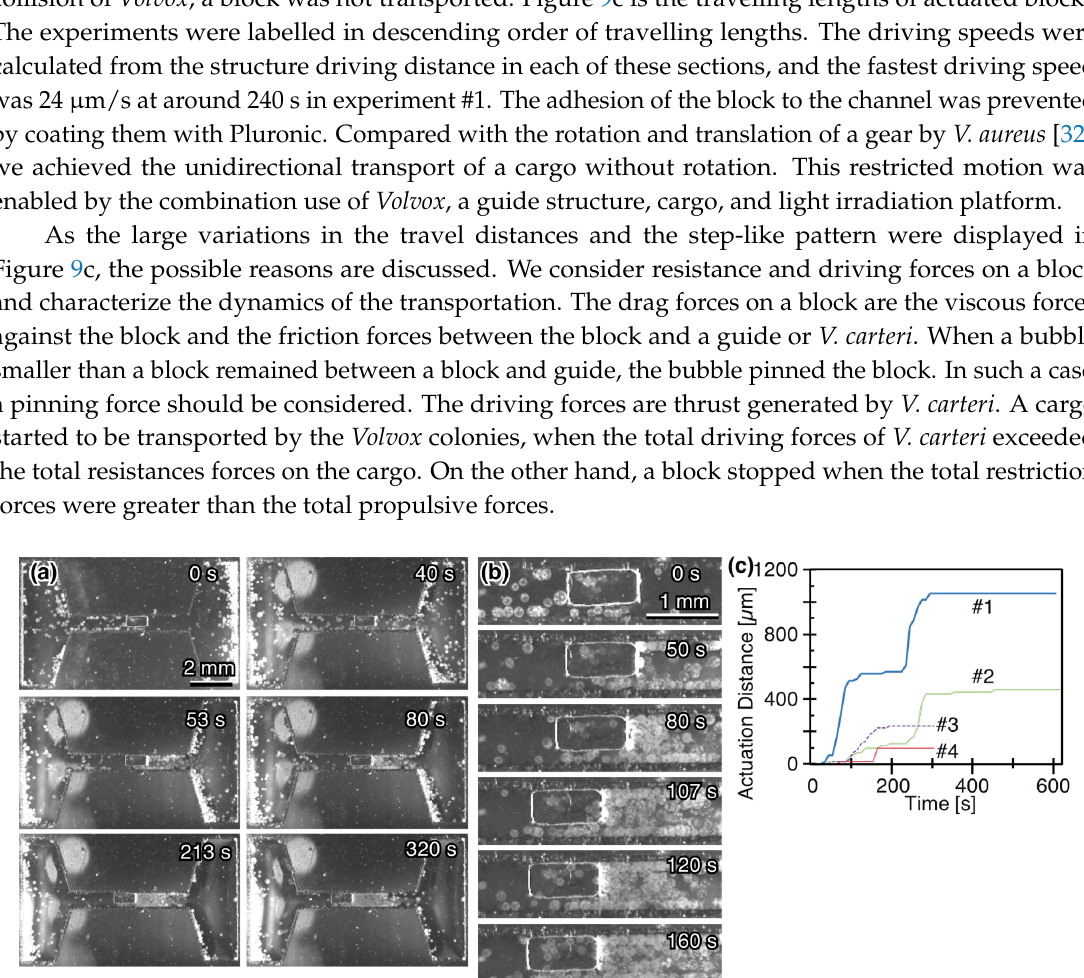
Figure 9. Unidirectional transport of a block in a microchannel. Time series micrographs showing the actuation results of a block in ( a ) the whole chamber and ( b ) the central region. A 500 μ m width block was put in a 710 μ m width channel. ( c ) Travel distances of the actuated blocks by V. carteri . The data were labeled as #1–4 based on the travel length order. #1–3 and #4 were taken with a 500 μ m and 750 μ m width blocks in a 710 μ m and 970 μ m width channel, respectively.